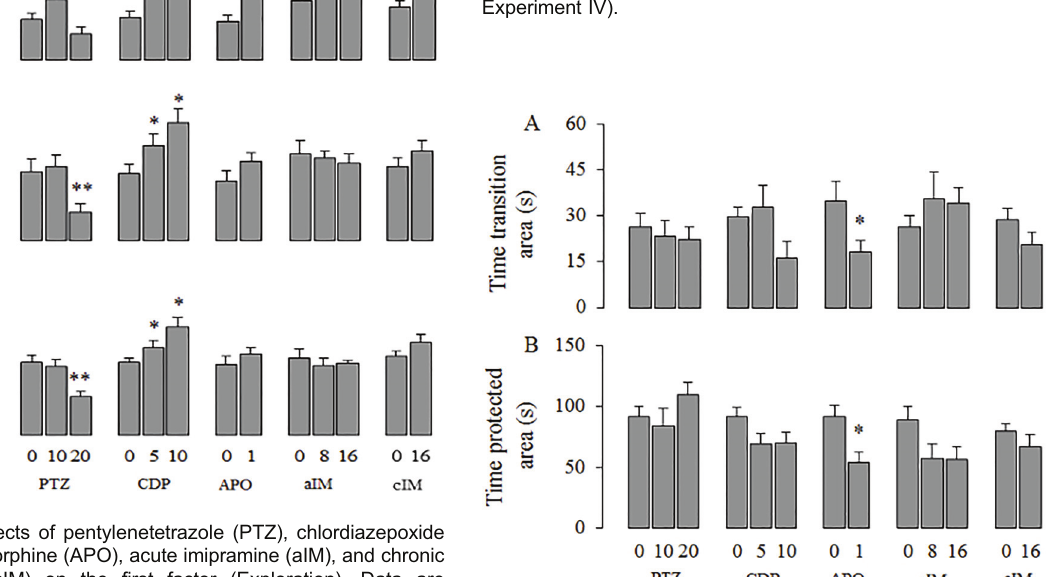
Figure 4. Effects of pentylenetetrazole (PTZ), chlordiazepoxide (CPD), apomorphine (APO), acute imipramine (aIM), and chronic imipramine (cIM) on the second factor (Impulsivity). Data are reported as means ± SE. *P o 0.05 compared to control vehicle; **P o 0.05 compared to the other doses. The following statistical tests were used: one-way ANOVA followed by Duncan ’ s post hoc test, Kruskal-Wallis followed by Dunn ’ s post hoc test, Student ’ s t -test, or Mann-Whitney test (for details, see Results section of